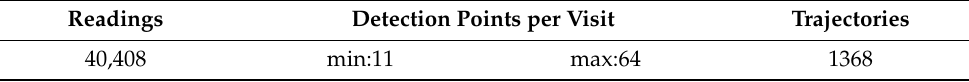
Table 1. Total number of positional marks and trajectories over the studied period. Readings Detection Points per Visit